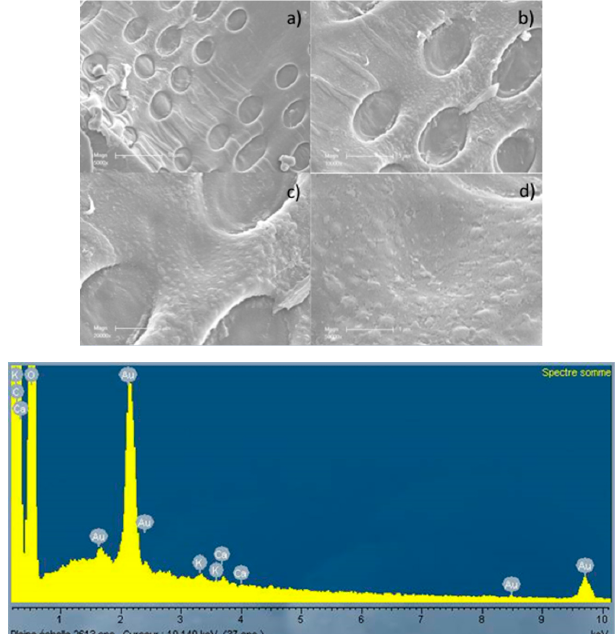
Figure 2. SEM photographs and X-ray fluorescence analysis of the surface of the raw wood particles at different enlargements ( a ) ×5000; ( b ) ×10,000; ( c ) ×20,000; and ( d ) ×50,000.